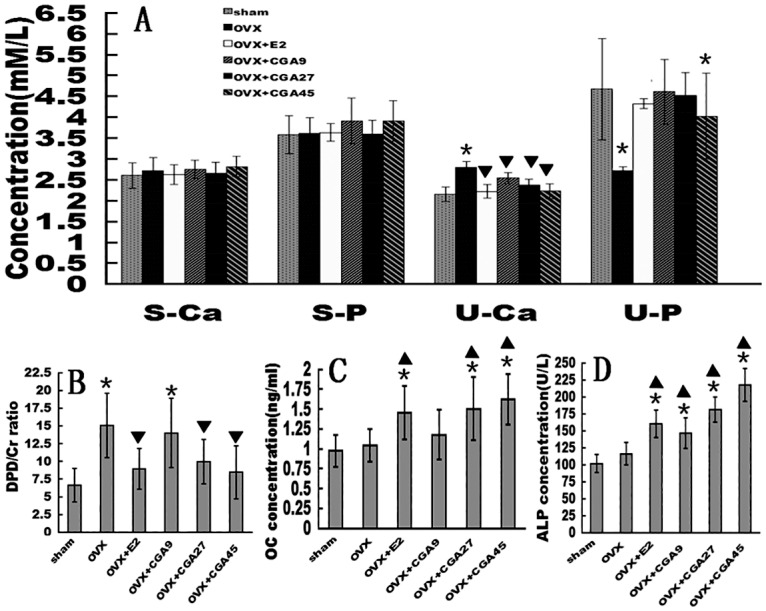
Effects of E2 and CGA on biochemical markers of bone remodeling in OVX rats.Rats were treated for a total of 12 wks. Each column represents the mean ± SD of 10 rats. *p < 0.01 vs. sham group. ▼decrease vs. OVX group (p < 0.01) ▲ increase vs. OVX group (p < 0.01). (A)S-Ca, S-P, U-Ca, and U-P of OVX rats in response to E2 and CGA. (B) Urinary DPD/Cr ratio of OVX rats in response to E2 and CGA. (C) Serum OC of OVX rats in response to E2 and CGA. (D) Serum ALP activity of OVX rats in response to E2 and CGA.